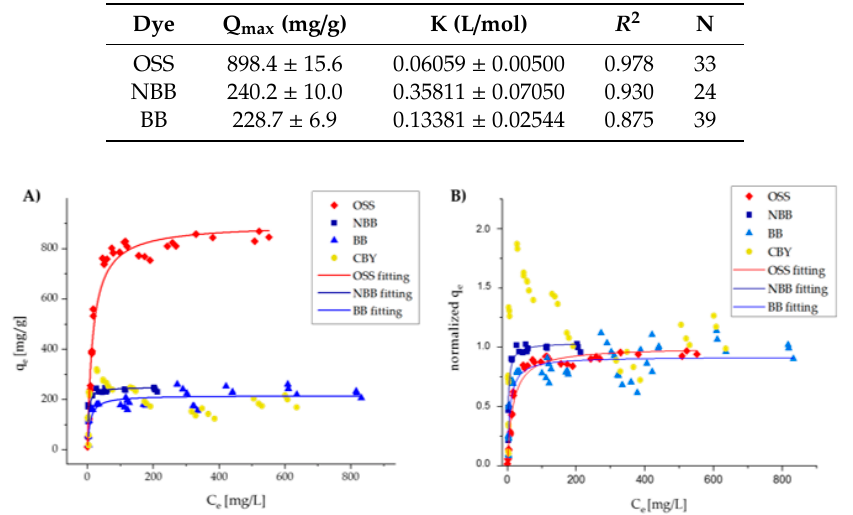
Table 3. Estimation of Q max and K parameters according to the Langmuir isotherm model for OSS, NBB and BB. The number of experimental data used for each dye is reported in column N.